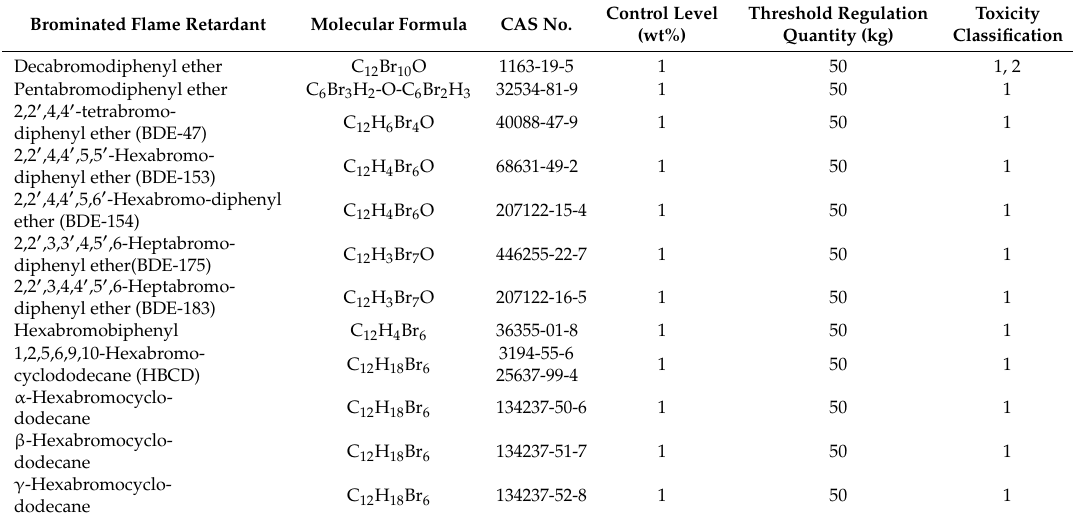
Control Level Threshold Regulation Toxicity (wt%) Quantity (kg) Classification